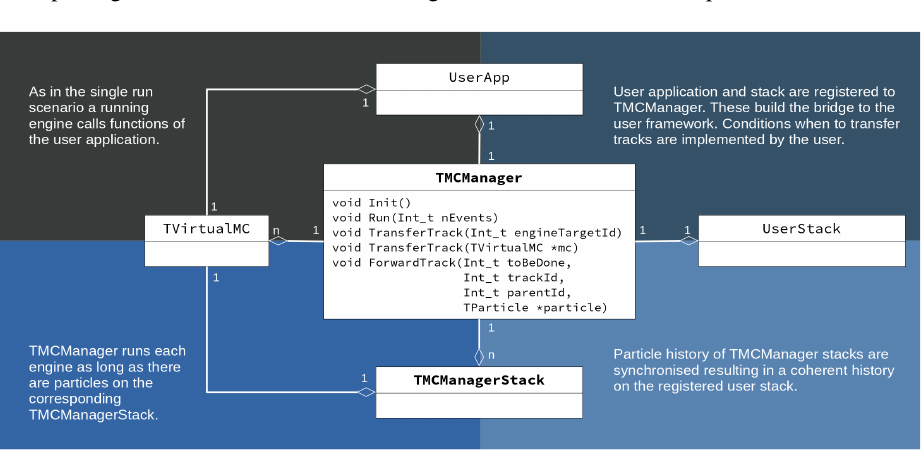
Figure 2. Sketch of the general VMC workflow. Boxes represent additional interaction between a VMCEngine and UserApp